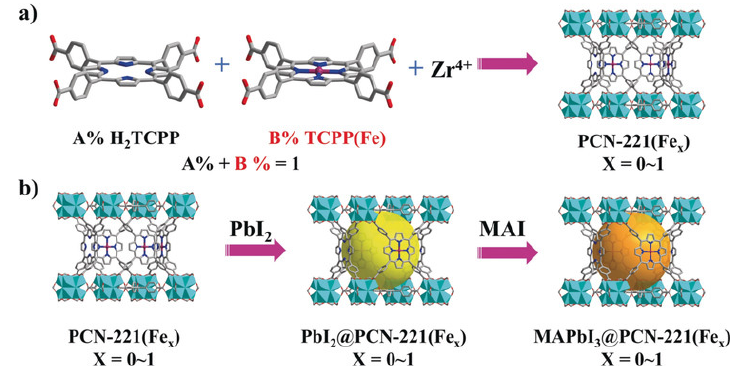
Figure 7. Schematic illustrations of the synthesis of ( a ) PCN ‐ 221(Fe x ) and ( b ) MAPbI 3 QDs (large spheres) encapsulated in the pores of PCN ‐ 221(Fe x ) by a sequential deposition route (MAI = CH 3 NH 3 I). Reproduced with permission from [121]. Copyright 2019, Wiley ‐ VCH.